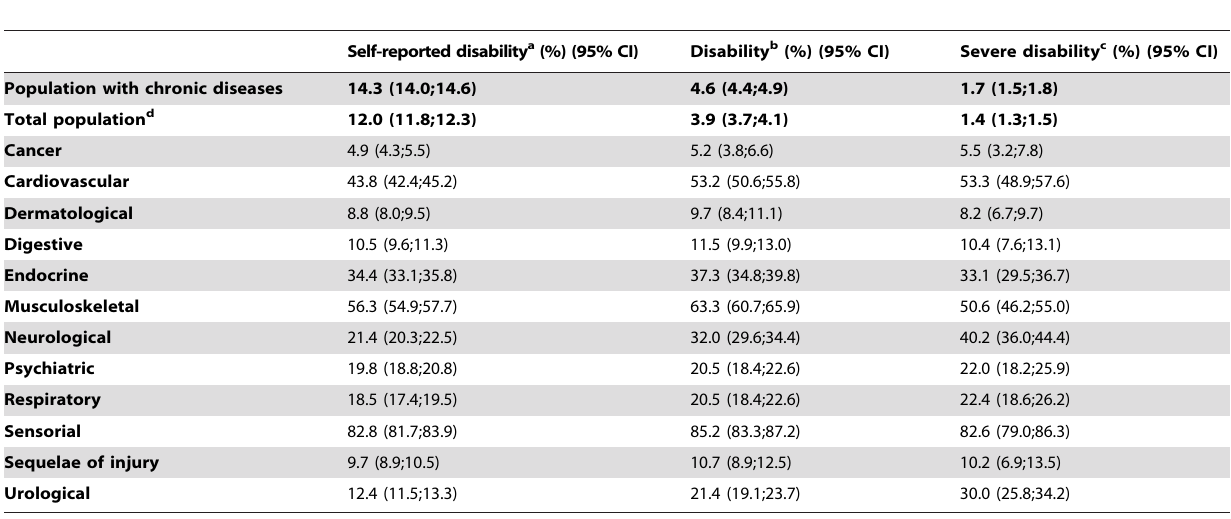
Table 3. Estimated frequency of each chronic condition in different situations of disability for people in France based on responses to the Disability-Health Survey.